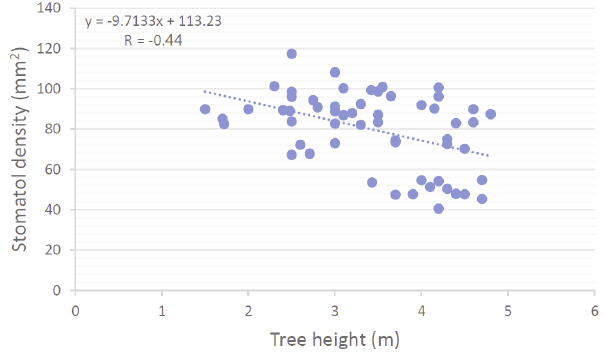
Fig. 5 ­ Pearson’s correlation coefficients between stomatal den­ sity and tree height in 19 Iranian pomegranate